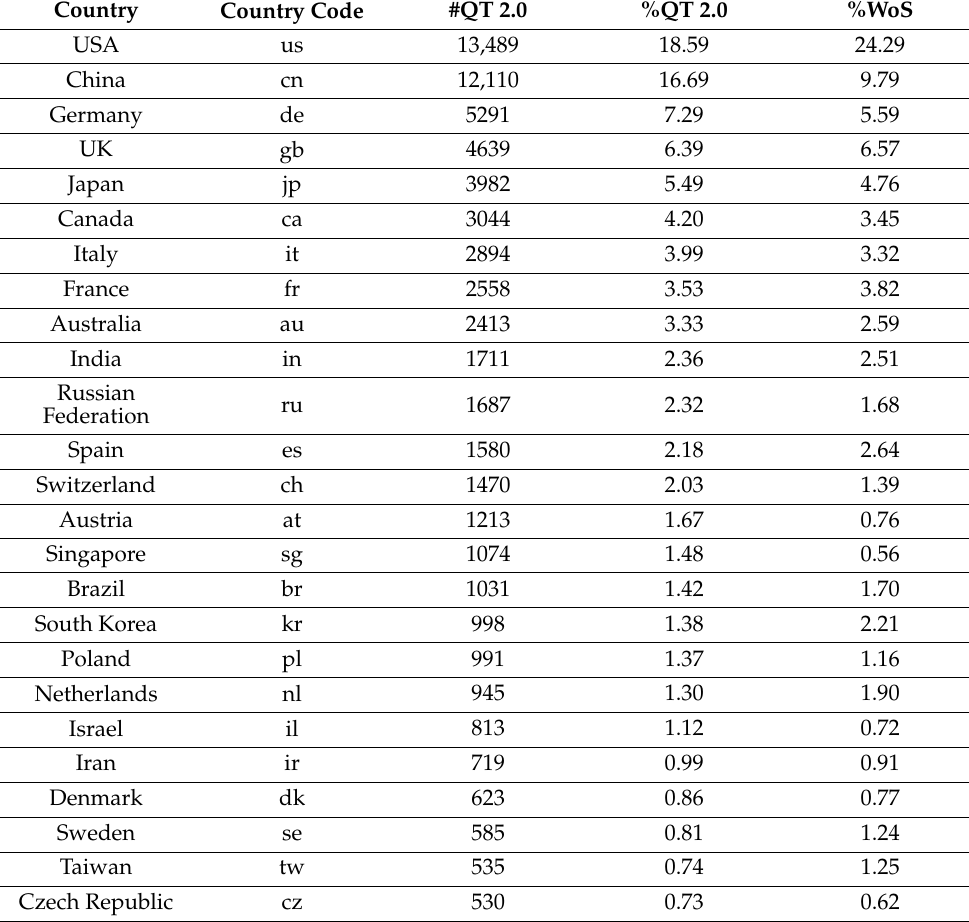
Table 3. The 25 top publishing countries with at least 500 papers in QT 2.0 for the years 2000 to 2018. The table shows the number of papers, their percentage, and the national share of the whole